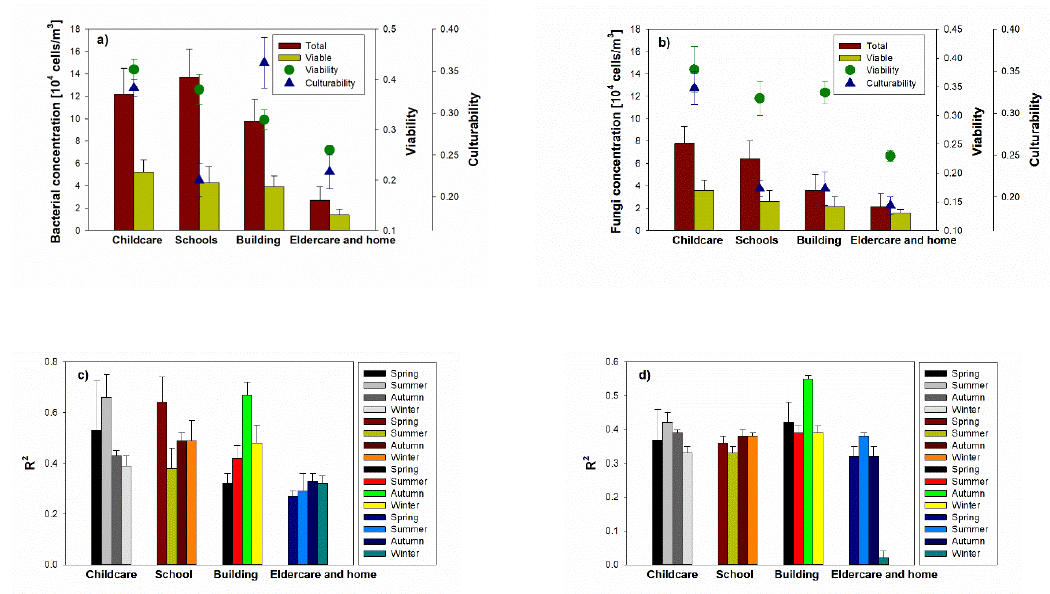
Figure 5. Concentrations of total bioaerosols, viability, culturability and the relationship between PM and viable bioaerosol observed in di ff erent indoor environments (childcare facility, school, commercial building and elderly and homes). ( a , b ) calculated viability and culturability for bacteria cells and fungal cells, respectively and ( c , d ) a linear relationship with coe ffi cient of determination (R 2 ) between viability and culturability for bacterial cells and fungal cells,